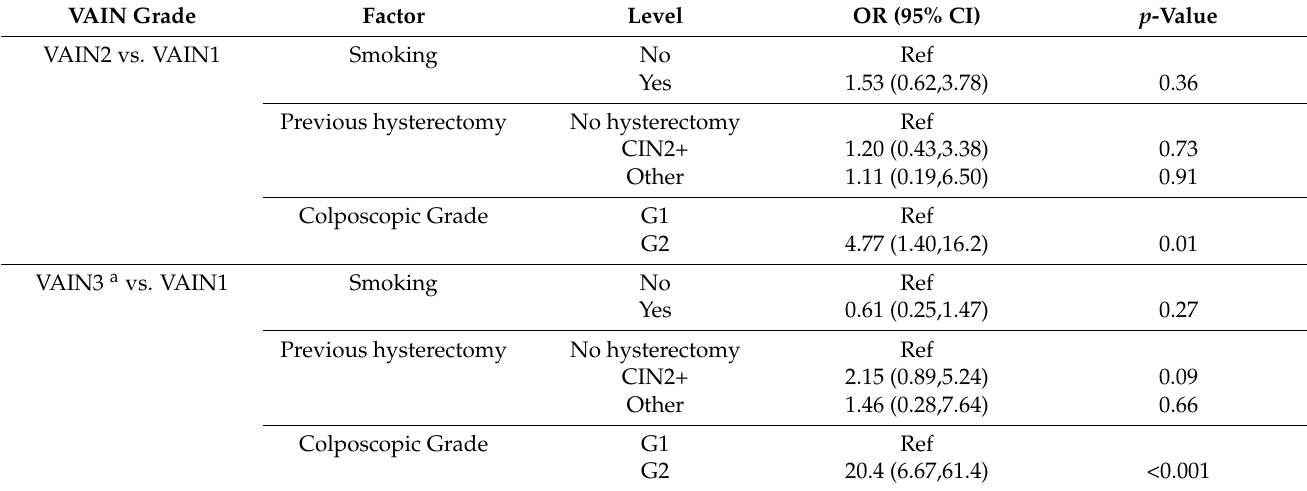
Table 4. Multivariate analysis of variance of risk factors for VAIN excluding lesion type and vascularity.